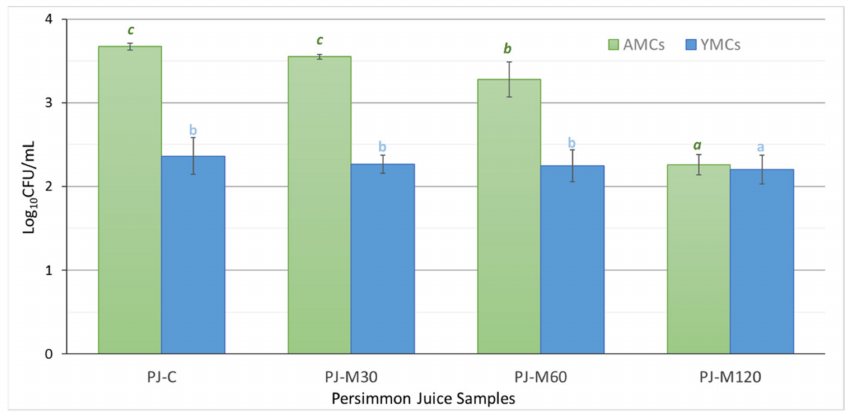
Figure 2. Changes in the population (log 10 CFU/mL) of aerobic mesophilic counts (AMCs) and yeasts and molds counts (YMCs) in persimmon juice produced without (PJ-C) and after persimmon pulp treatment at different microwave heating conditions (PJ-M30, PJ-M60, and PJ-M120). Error bars represent the standard deviation (sd) of the mean value ( n = 4). Different lowercase letters in the same substrate indicate significant differences ( p < 0.05).